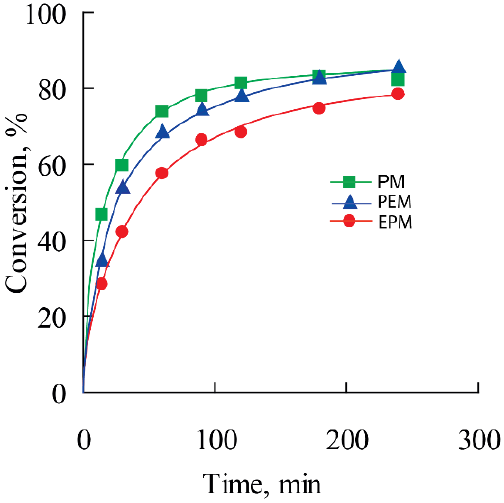
Figure 8. Dependencies of monomer conversion on time: EPM ( ● ), PEM ( ▲ ), PM ( ■ ). Table 1. The polymers characteristics.